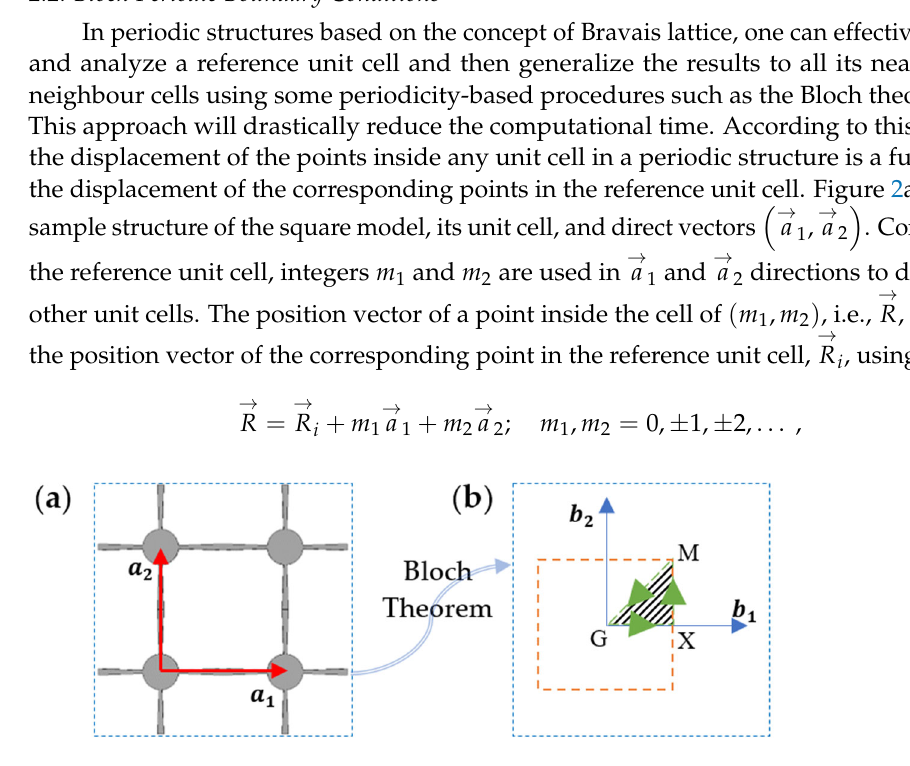
Figure 2. Schematic of in-plane periodic architected metamaterial: ( a ) a periodic sample structure and its direct unit cell vectors; ( b ) FBZ (orange dotted empty square) and IBZ (green dotted hatched triangular area) of the square unit cell.